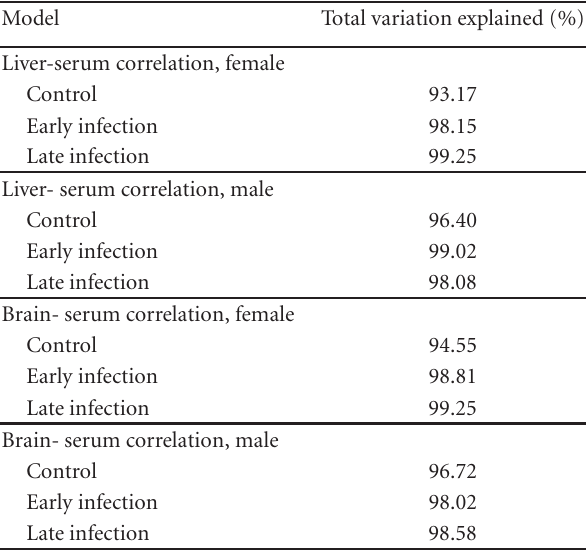
Table 2: MPCA model statistics in terms of total explained variances by two PCs calculated in